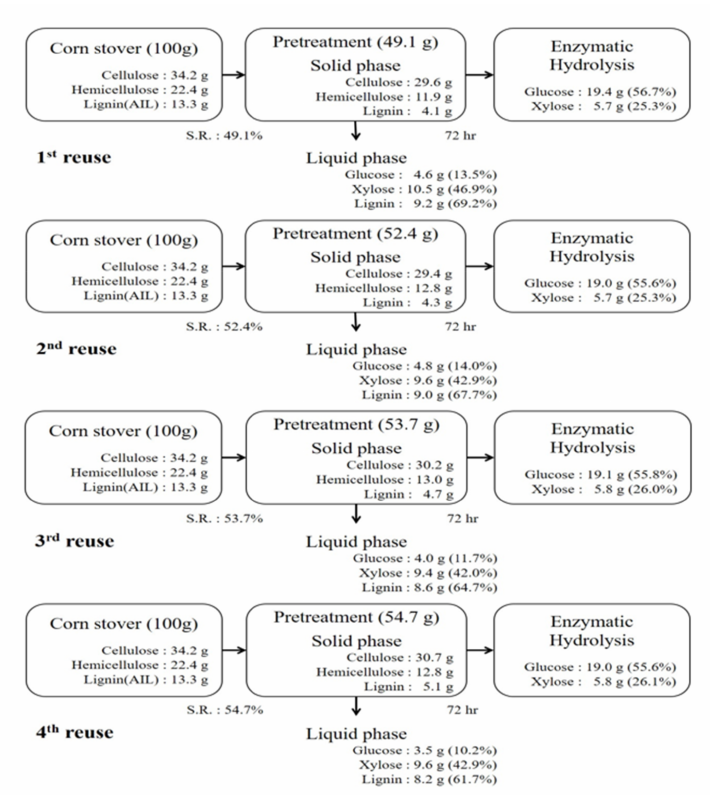
Figure 4. Mass balance of pretreated corn stover by reused organosolv. Note. All numbers in the liquid phase represent the components removed by each step (not accumulated